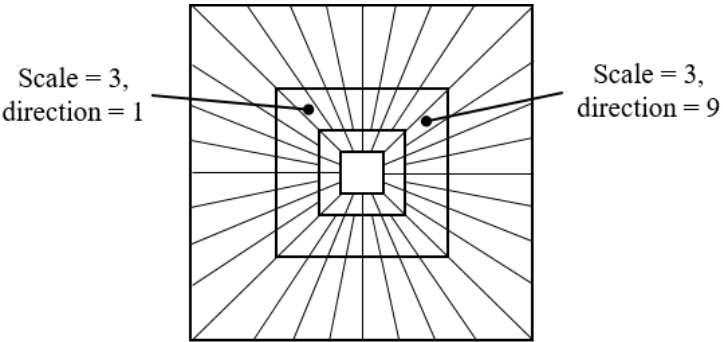
Figure 6. Frequency spectrum coverage of curvelet transform. The curvelet decomposes the frequency domain into various scales and directions.